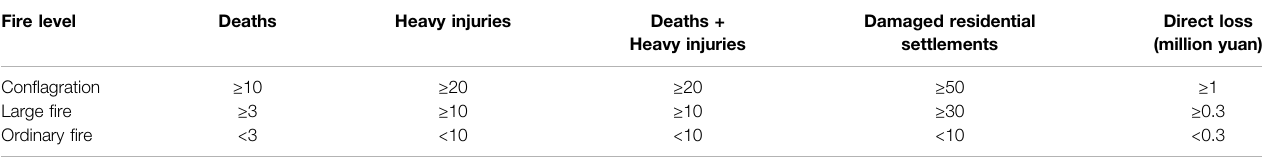
TABLE 1 | Standards for fi re level before 2007.